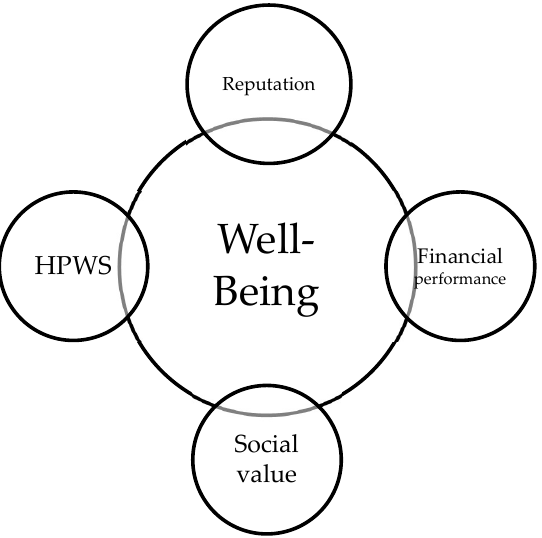
Figure 1. Research model. (Source: Own elaboration).